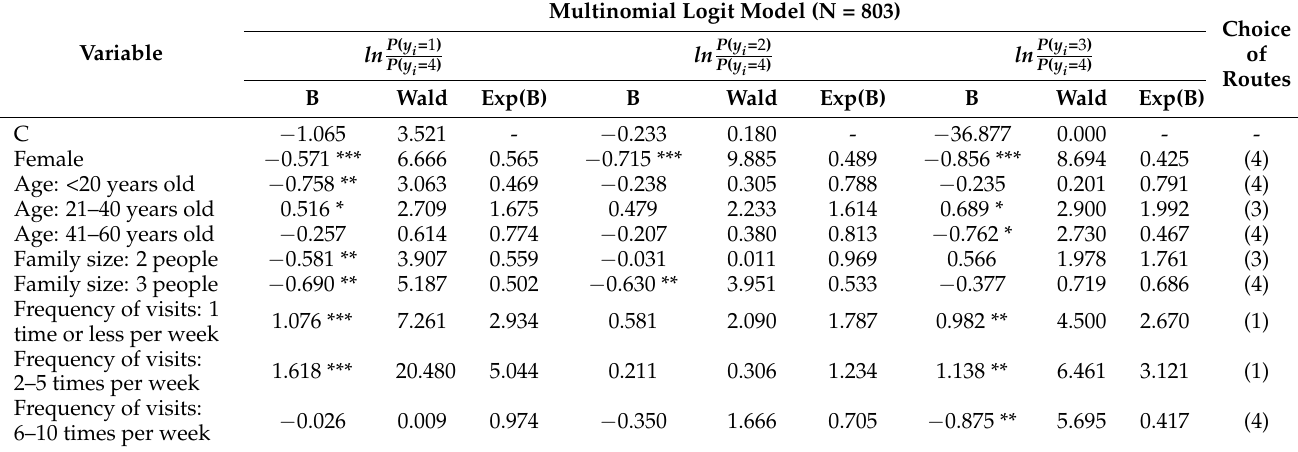
Table 5. Maximum likelihood estimation of multinomial logit regression for four urban forest park routes. Variable